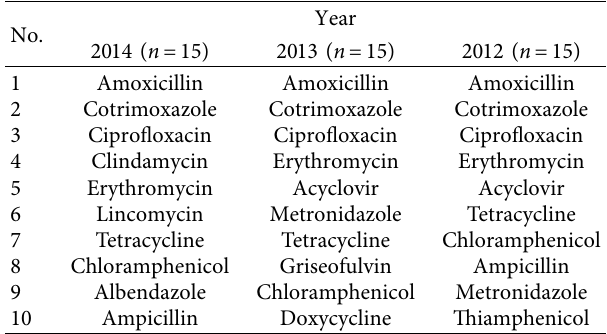
Table 2: The ranking of 10 antimicrobials mostly commonly used in primary health cares (15 districts of 8 provinces).